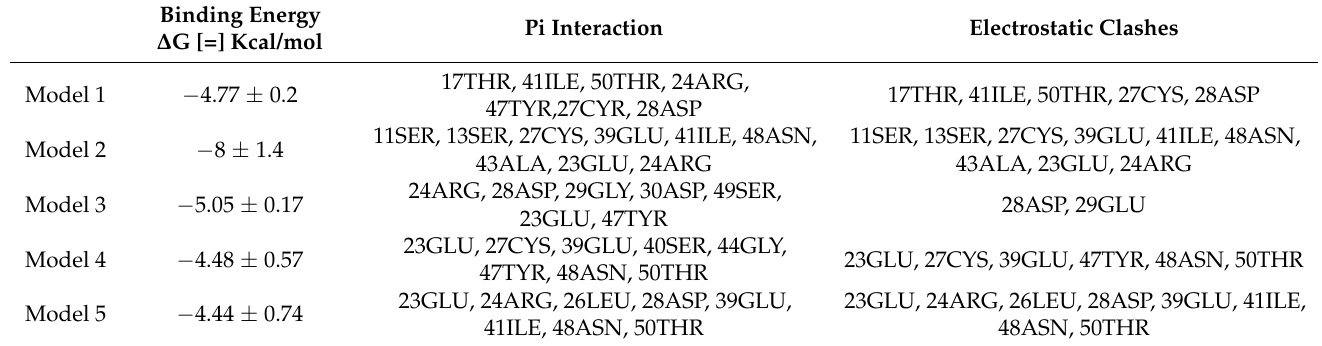
Table 2. Binding of angiopep-2 to CR17 of LRP-1: characteristic binding energy and classification of receptor residues involved in the